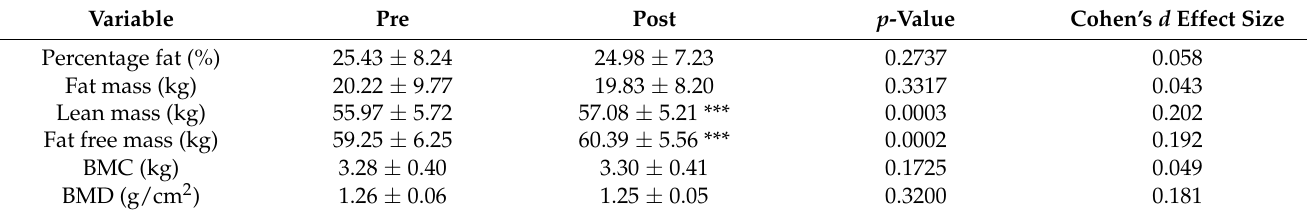
Table 3. Change in body composition following 8 weeks of Pilates training in adolescent baseball